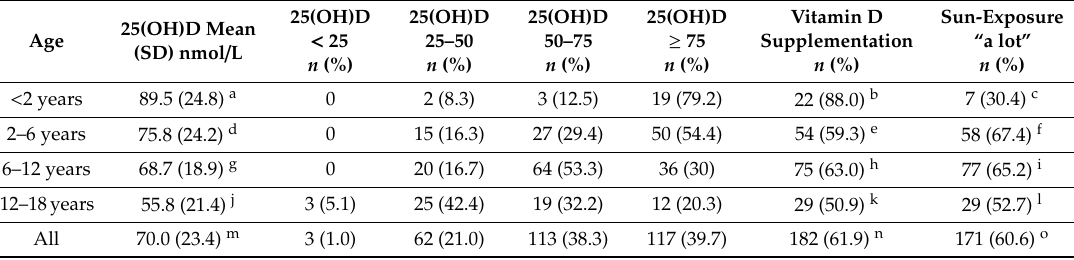
Figure 1. Plasma 25(OH)D levels according to month of the year in Norwegian children. Predicted mean and 95% CI during month 1 (January) to 12 (December). Table 3. 25(OH)D levels, vitamin D supplementation and sun-exposure by age